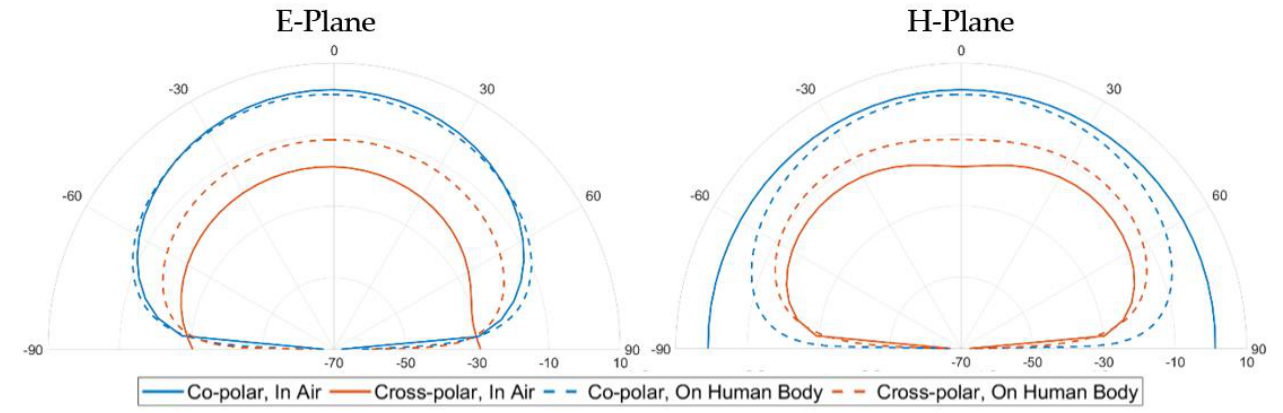
Figure 8. Simulated radiation pattern for the Minkowski pre-fractal-shaped PIFA placed on human body tissue compared to the Minkowski pre-fractal-shaped PIFA in air.